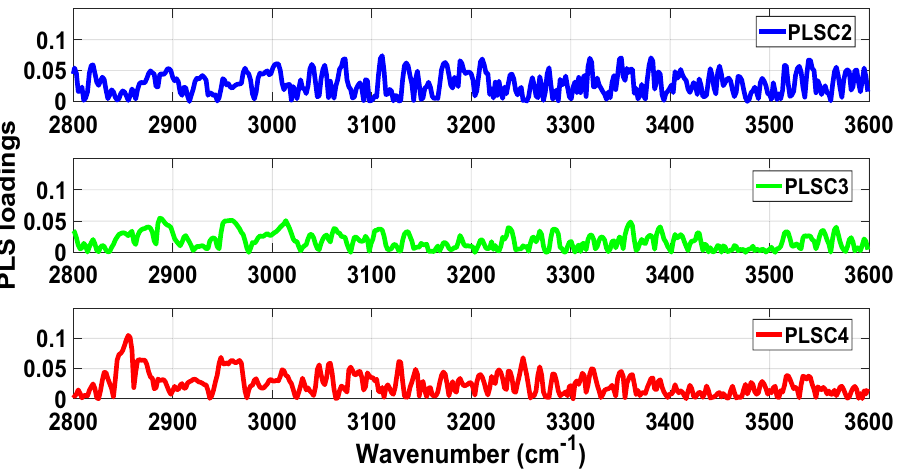
Figure 9. Absolute values of PLS loadings of PLSC2 (blue), PLSC3 (green) and PLSC4 (red) in the high wavenumber spectral region between 2800–3600 cm −1 for our analysis of the LIQUID 2 dataset.